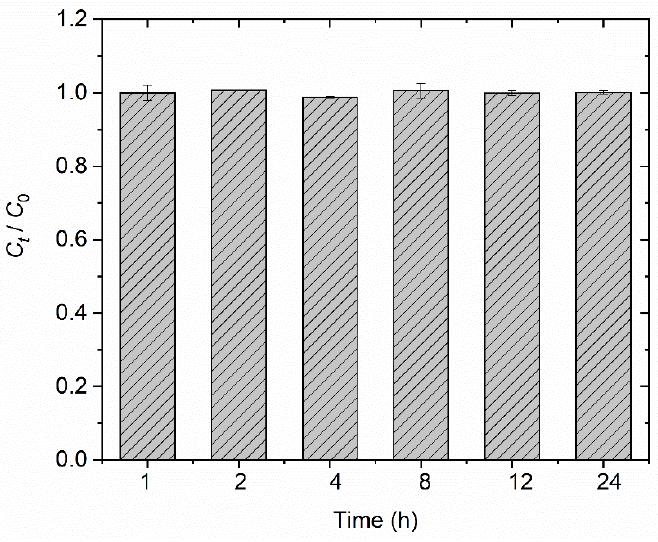
Figure 1. The changes of C t / C 0 for MTAs V solutions over time in the blank